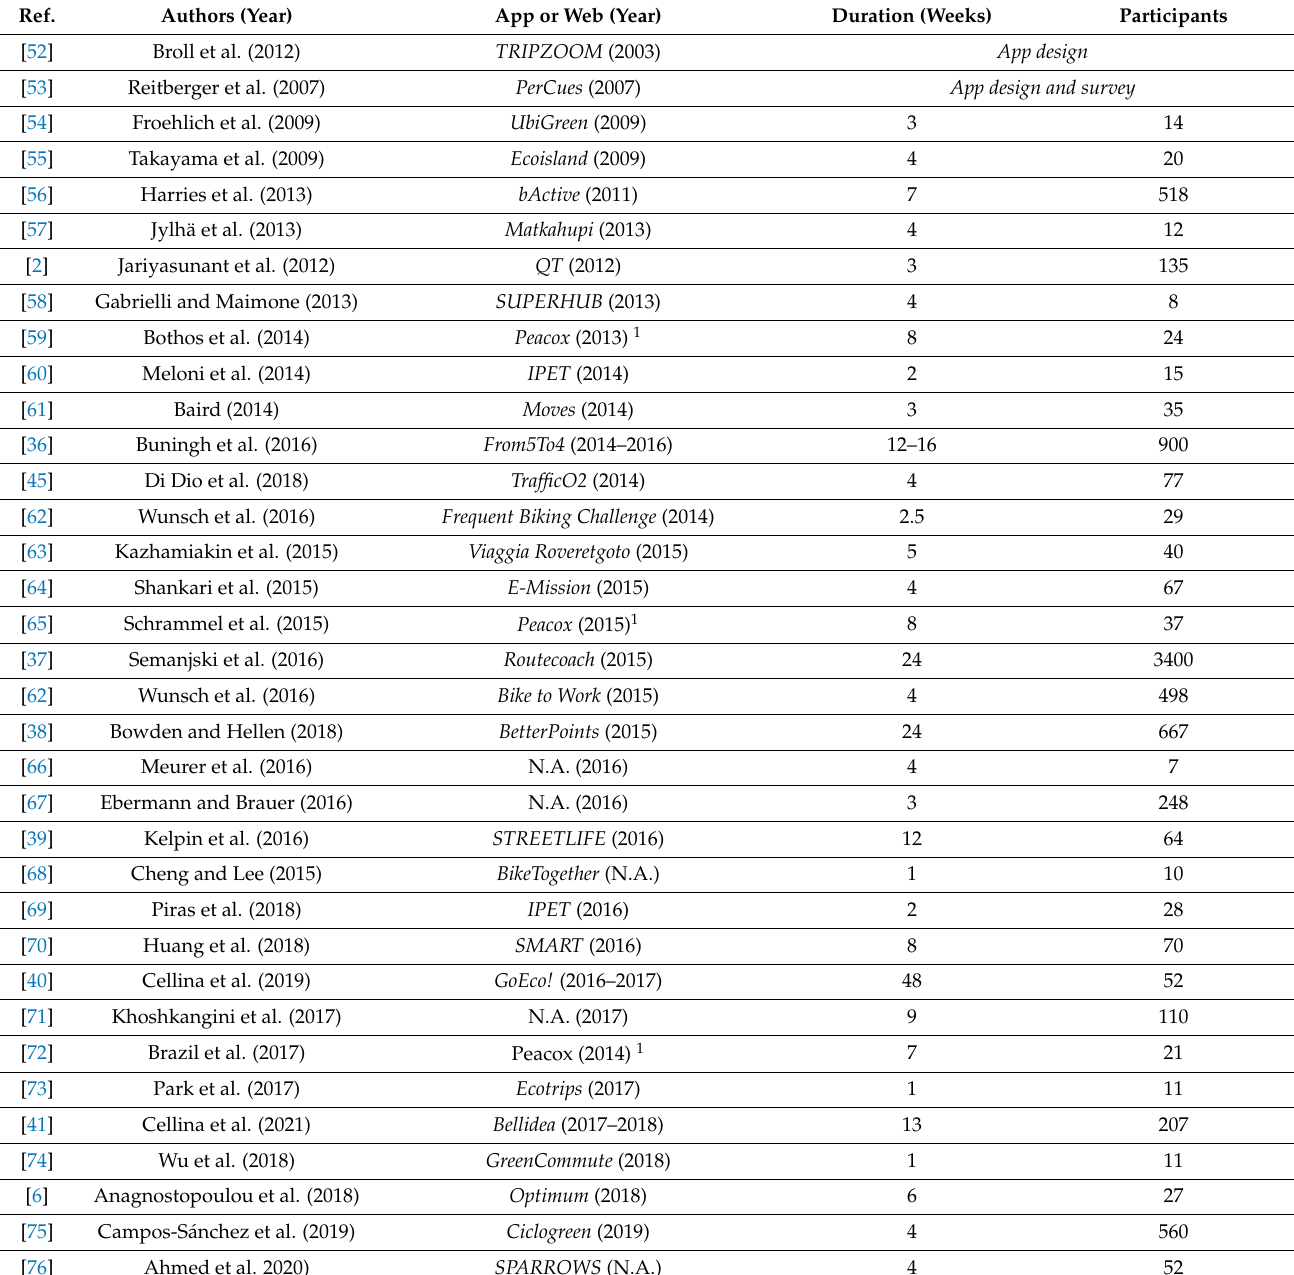
Table A2. App and web based persuasive systems for encouraging sustainable